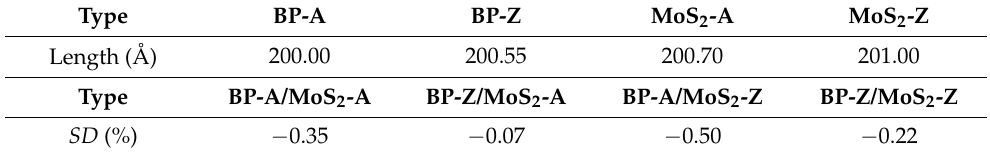
Figure 1. ( a ) and ( b ) show the molecular models of SLBP and SLMoS 2 , respectively. The structures in the red dotted box are the representative unit cells selected in this paper; ( c ) illustrates the bidirectional bending models of BP-Z/MoS 2 -A (bending angle is 180 ◦ ) formed by the stacking of BP-Z and MoS 2 -A. The green and blue arrows represent bending towards MoS 2 and BP, respectively. The inset is the perspective view of BP-Z/MoS 2 -A with a cylindrical shell structure. The light blue section is the traction area consisting of coaxial springs. The blue broken lines represent springs. The red point is the central axis of curvature of the cylindrical shell structure. Table 1. The characteristic sizes of SLBP, SLMoS 2 , and BP/MoS 2 with four types of stacking orders.